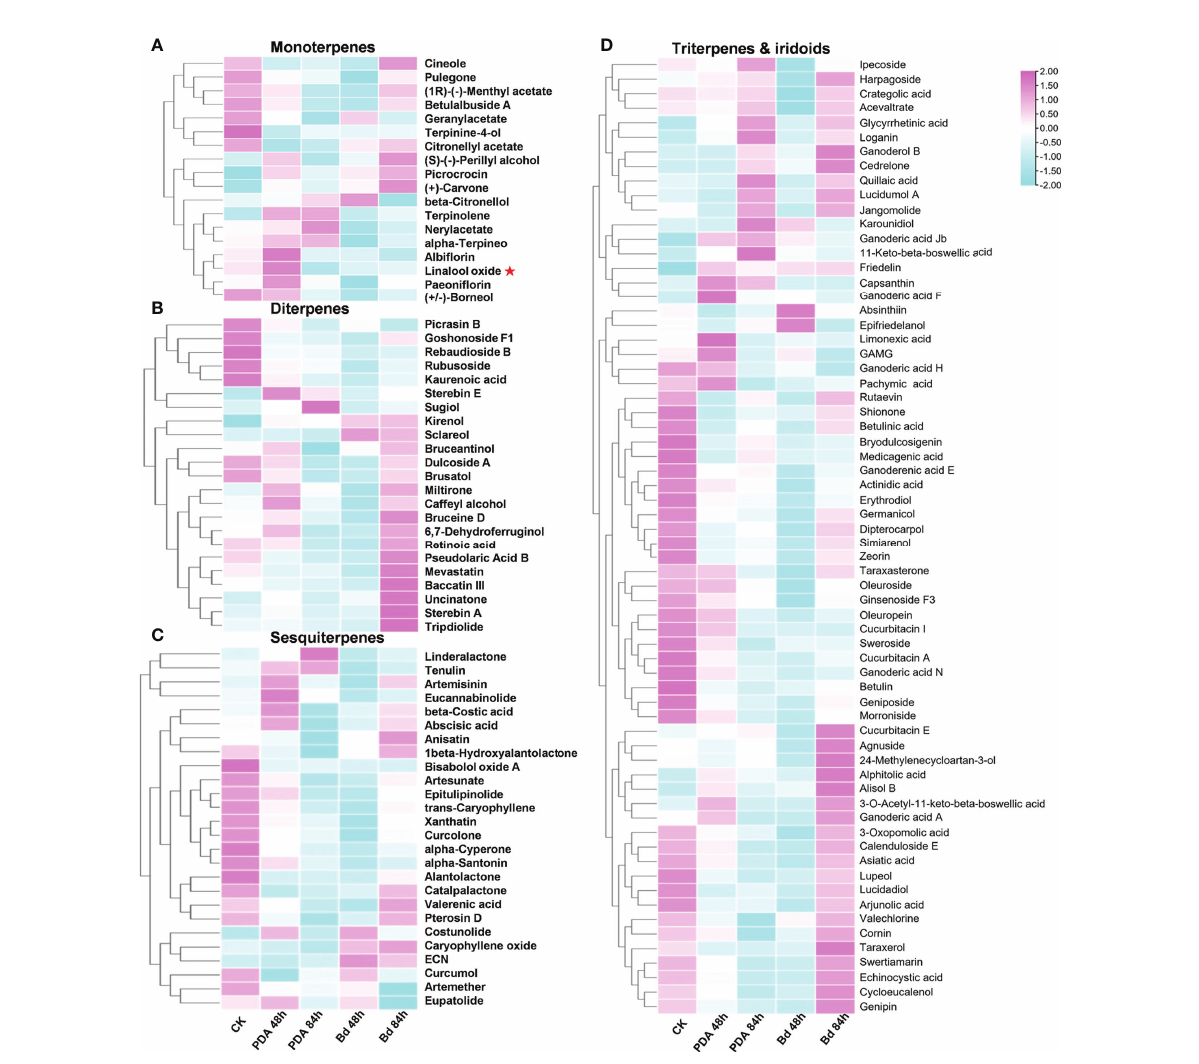
FIGURE 4 The relative contents of 133 terpenoids in peach shoots post B. dothidea inoculations determined by UHPLC-MS. (A – D) Heatmaps show the relative content of eighteen monoterpenes (A) , twenty-three diterpenes (B) , twenty-six sesquiterpenes (C) , and 65 triterpenes and iridoids (D) in the shoot of ‘ Huyou018 ’ after PDA medium (Mock) and B. dothidea inoculations, respectively. The color scale represents relative contents of terpenoids at each time point (0 h, 48 h, 84 h) with pink denoting relatively higher terpenoids contents and blue denoting relatively lower terpenoids contents. A red asterisk in (A) points out the linalool oxide. The detailed relative contents of 133 terpenoids were presented in Supplementary Table